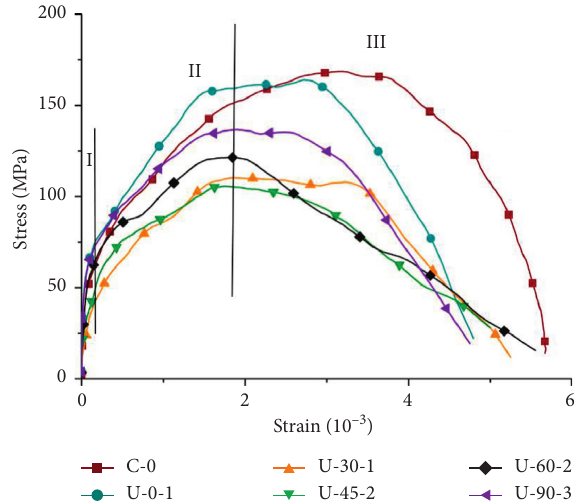
Figure 5: Dynamic stress-strain curves of precracked specimens.